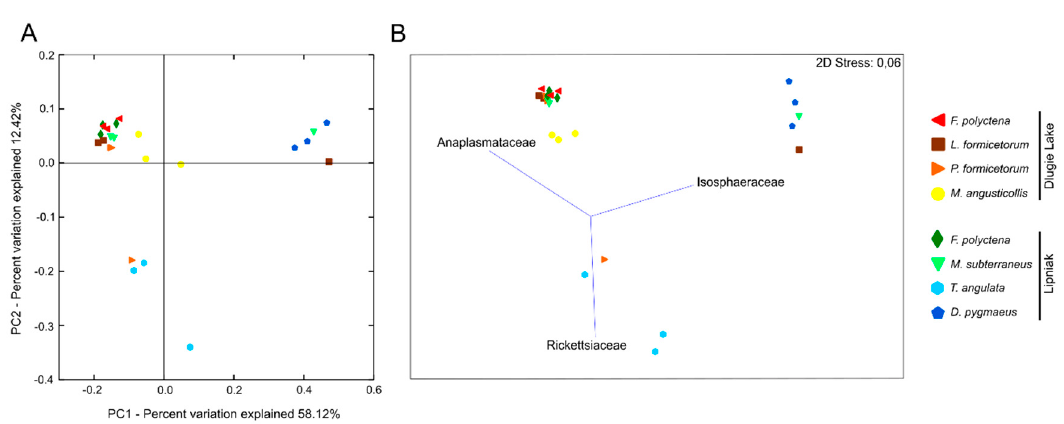
Figure 3. Principal Coordinate Analysis (PCoA) and Non-metric Multidimensional Scaling (nMDS) plots of the tested samples. ( A ) PCoA of bacterial communities associated with tested specimens based on weighted UniFrac distances; ( B ) nMDS based on Bray–Curtis dissimilarity between samples with identified vectors allowing to distinguish among clusters. Both plots show high overlap among F. polyctena , L. formicetorum , P. formicetorum , and M. angusticollis samples.